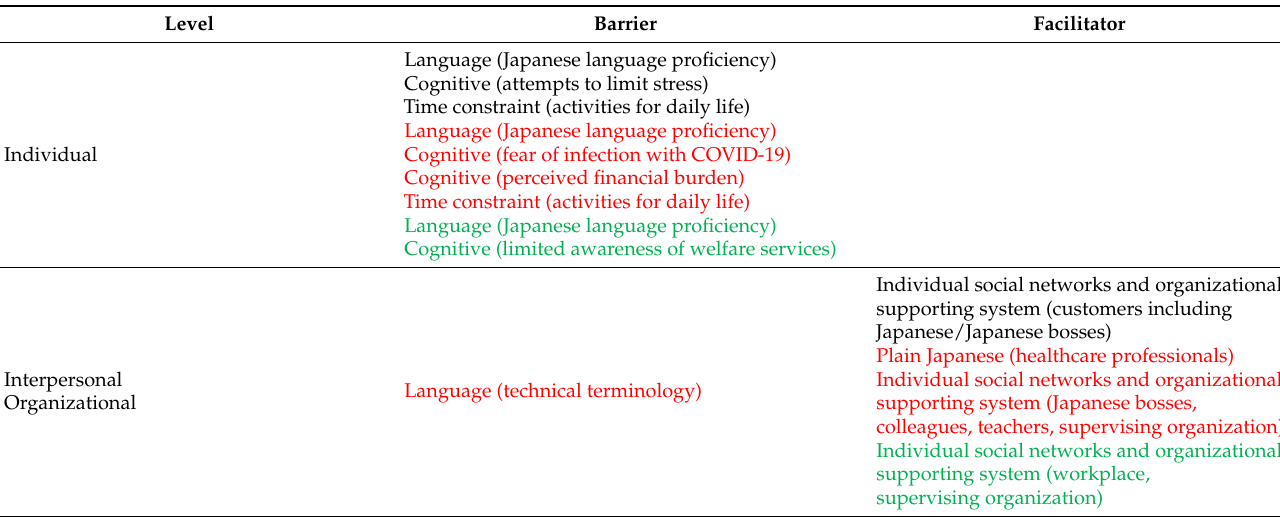
Table A2. Barriers to and facilitators of accessing health-related information and health and welfare services: an analysis with an adapted version of the ecological